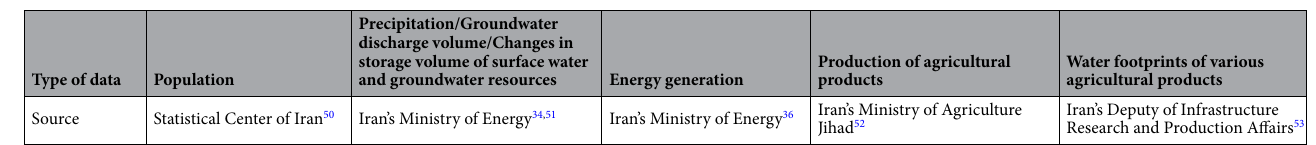
Table 2. General information for the study area and its